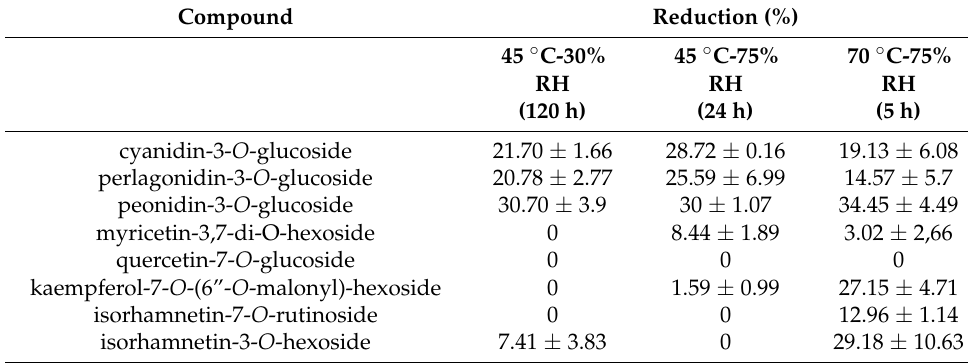
Table 3. Peak area relative reduction (%) of selected marker compounds present in MCE, monitored at the estimated isoconversion times (120 h, 24 h, and 5 h) for each treatment (45 ◦ C-30% RH, 45 ◦ C-75% RH, and 70 ◦ C-75% RH). All values were calculated as the mean of the relative reductions observed for the three tested batches.